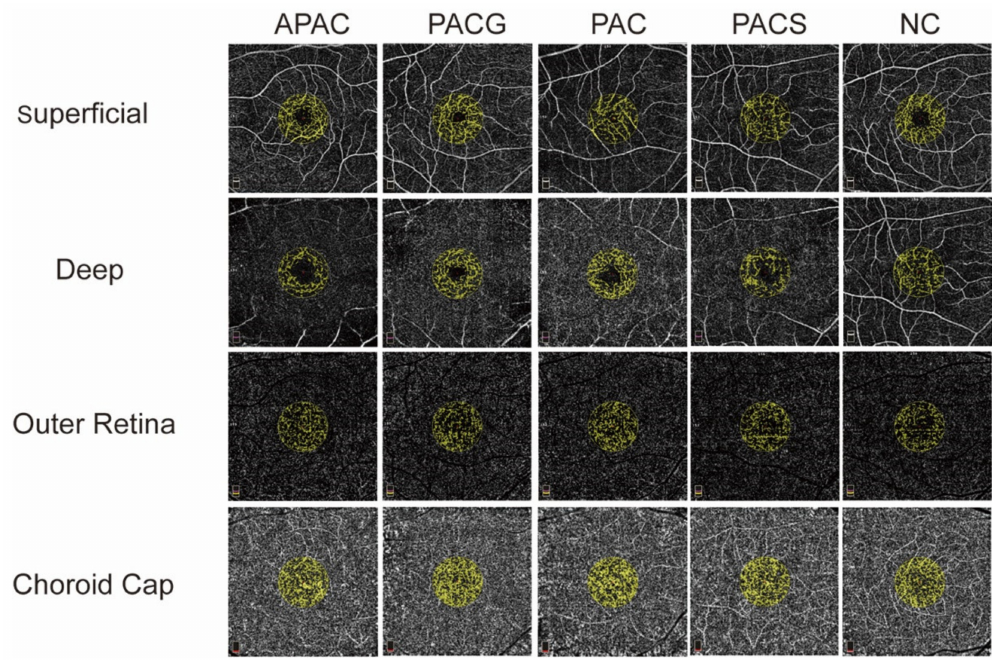
Figure 4. Image of macular flow area (FA). A comparison of the superficial, deep, outer retina, and choroid cap layers is presented. The FA was measured in a 1-mm radius of the foveal area (6 mm 2 × 6 mm 2 ) with a preset setting. APAC = acute primary angle-closure; PACG = primary angle-closure glaucoma; PAC = primary angle-closure; PACS = primary angle-closure suspect; NC = normal control.